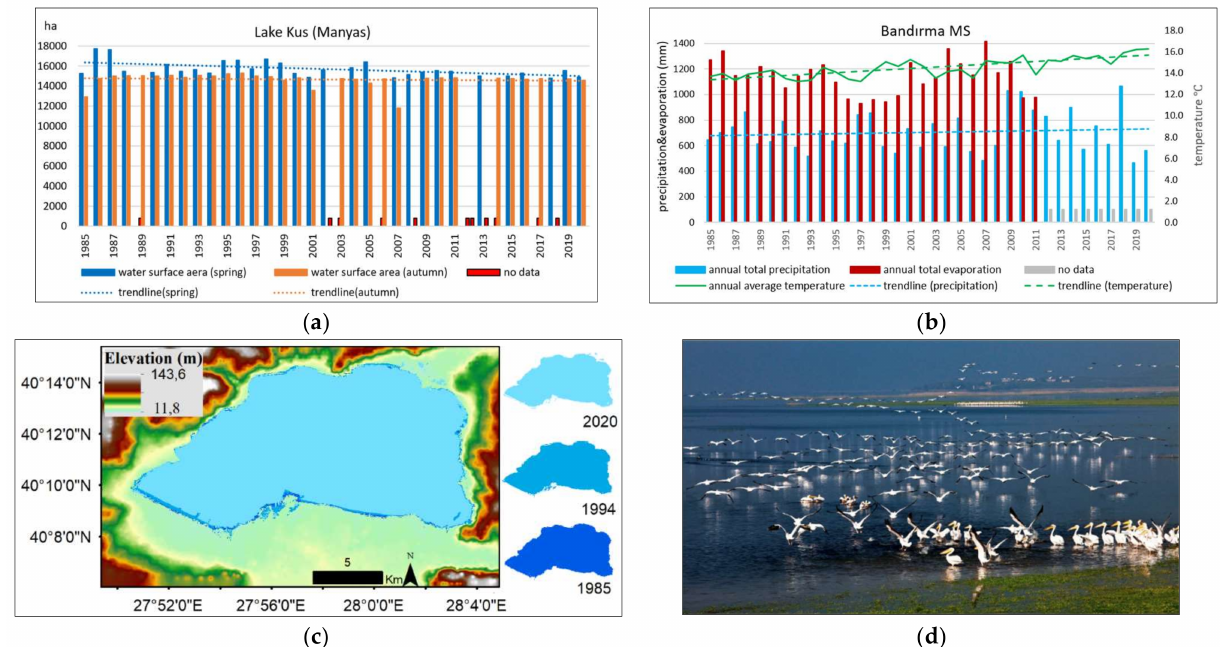
Figure 10. Lake Kus (Manyas): ( a ) 1985–2020 annual (spring and autumn) surface water areas; ( b ) representative meteoro- logical station data (precipitation, evaporation, and temperature); ( c ) water surface area changes (NDWI); ( d ) view of the site